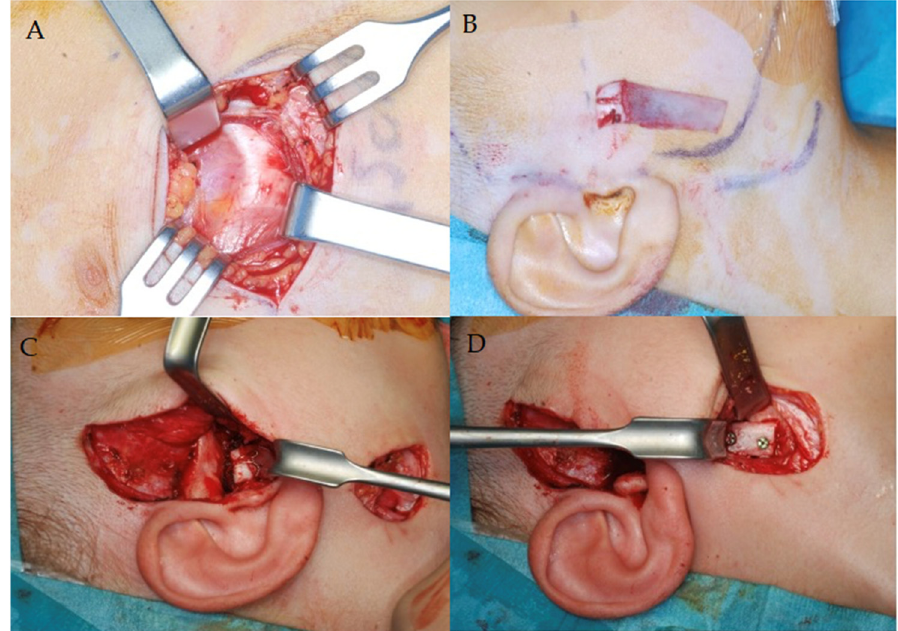
Figure 3. ( A , B ) The CCG was harvested from the fifth right rib and then modeled to the exact shape and dimension needed; ( C , D ) The CCG is then fixed into place to form the new joint.